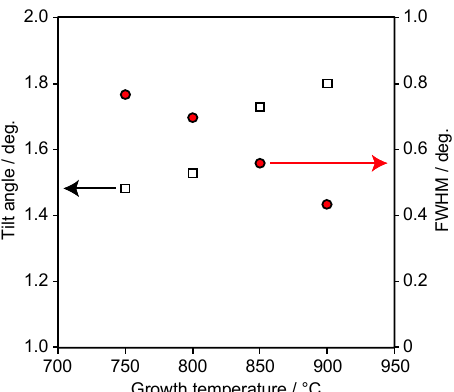
Figure 4. Tilt angle and full width at half-maximum (FWHM) of the X-ray diffraction (XRD) ω -scan for ScN(200) as functions of the growth temperature. The open squares indicate the tilt angle of the ScN films. The red circles indicate the FWHM of the XRD ω -scan for ScN(200). The Sc source temperature is set to 1300 °C. The film’s thickness is in the range of 140–175 nm.